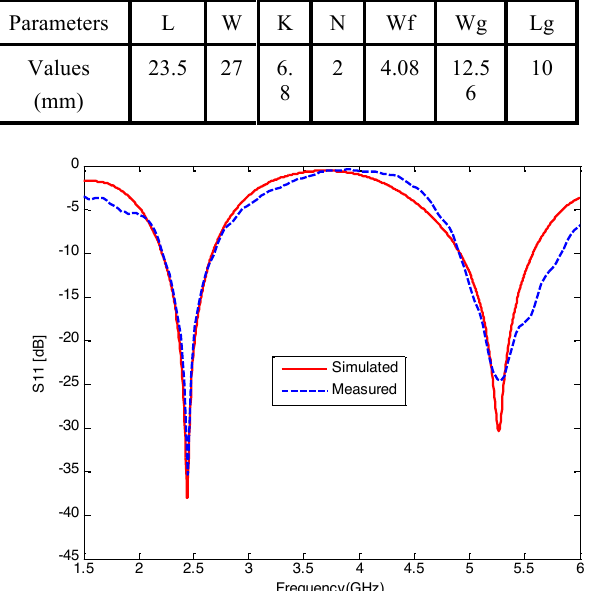
Table. 1: AMC unit cell dimensions